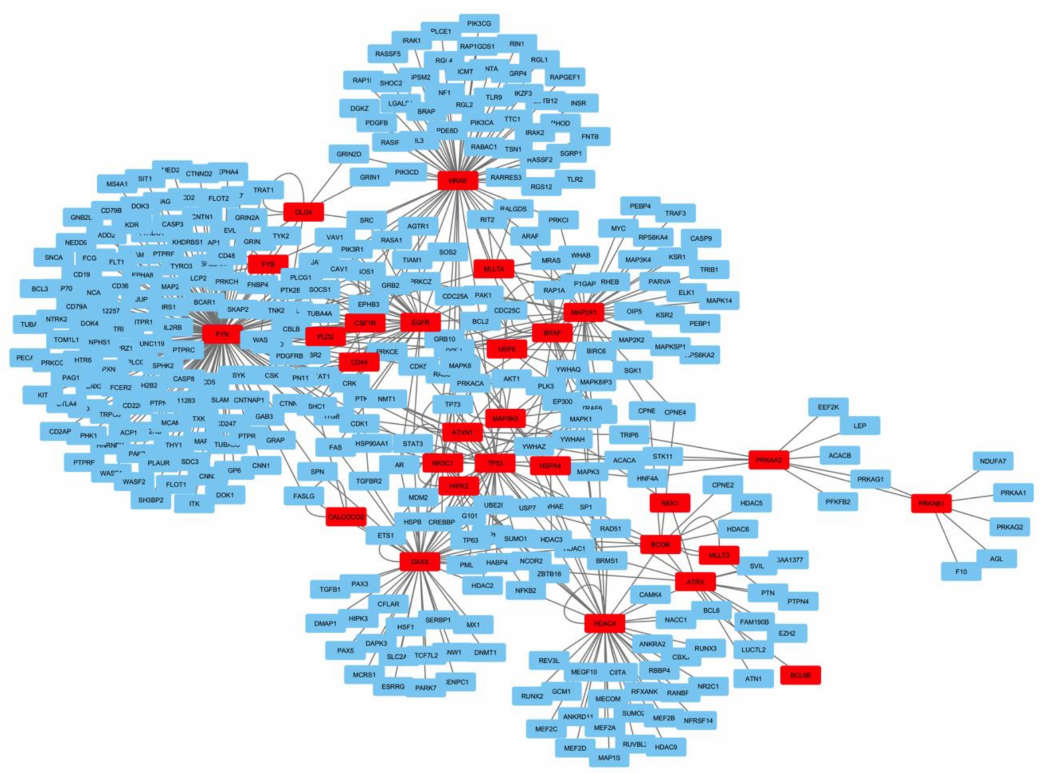
Figure 5. Bioinformatically engineered network representation of densely connected cluster nodes in CD having the highest impact on tumorigenesis. In red are represented mutated genes found in CD and in blue the main interaction partners in the cluster network (365 nodes, 576 edges) are